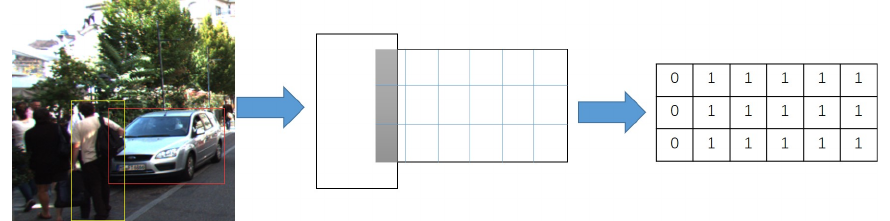
Figure 6. KITTI dataset